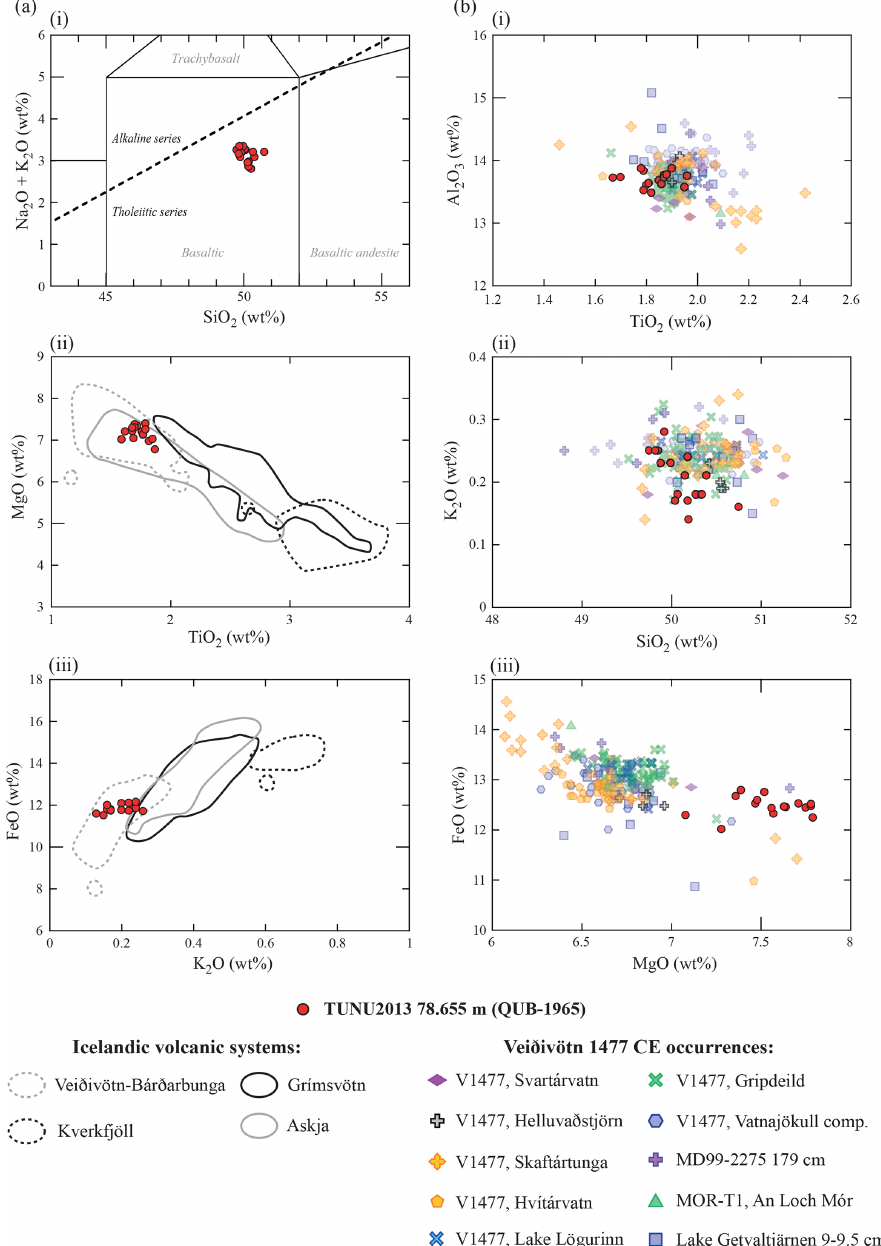
Figure 4. Geochemical characterisation of glass tephra shards from the TUNU2013 78.655m deposit with comparisons to Icelandic prox- imal material and analyses of Veiðivötn 1477CE occurrences. Panel (a) is as follows. (i) Inset of total alkali versus silica plot showing the tholeiitic basalt composition of the TUNU2013 78.655m deposit. Chemical classification and nomenclature after Le Maitre et al. (1989). Division line between alkaline and sub-alkaline material from MacDonald and Katsura (1964). (ii, iii) Geochemical characterisation of the TUNU2013 78.655m deposit compared to geochemical envelopes for several Icelandic tholeiitic volcanic systems. Geochemical envelopes derived from non-normalised whole rock and glass shard analyses from deposits proximal to the Icelandic volcanic systems; adapted from Óladóttir et al. (2020) and references within. Non-normalised TUNU2013 78.655m data utilised to permit a direct comparison with the published geochemical envelopes. Panel (b) is as follows. (i–iii) Comparisons of individual analyses from the geochemical characterisation of TUNU2013 78.655m to characterisations of several Icelandic and non-Icelandic occurrences of the Veiðivötn 1477CE eruption. Geo- chemical data for V1477 occurrences from Svartárvatn (Larsen et al., 2002), Helluvaðstjörn (Lawson et al., 2007), Skaftártunga (Streeter and Dugmore, 2014), Hvítárvatn (Larsen et al., 2011), Lake Lögurinn (Gudmundsdóttir et al., 2016), Gripdeild (Bergþórsdóttir, 2014), a compi- lation of six sites around the Vatnajökull ice cap (Óladóttir et al., 2011), MD99-2275 (Larsen et al., 2002; Gudmundsdóttir et al., 2011), An Loch Mór (Chambers et al., 2004) and Lake Getvaltjärnen (Davies et al., 2007). All data are provided in the Supplement and plotted on a normalised anhydrous